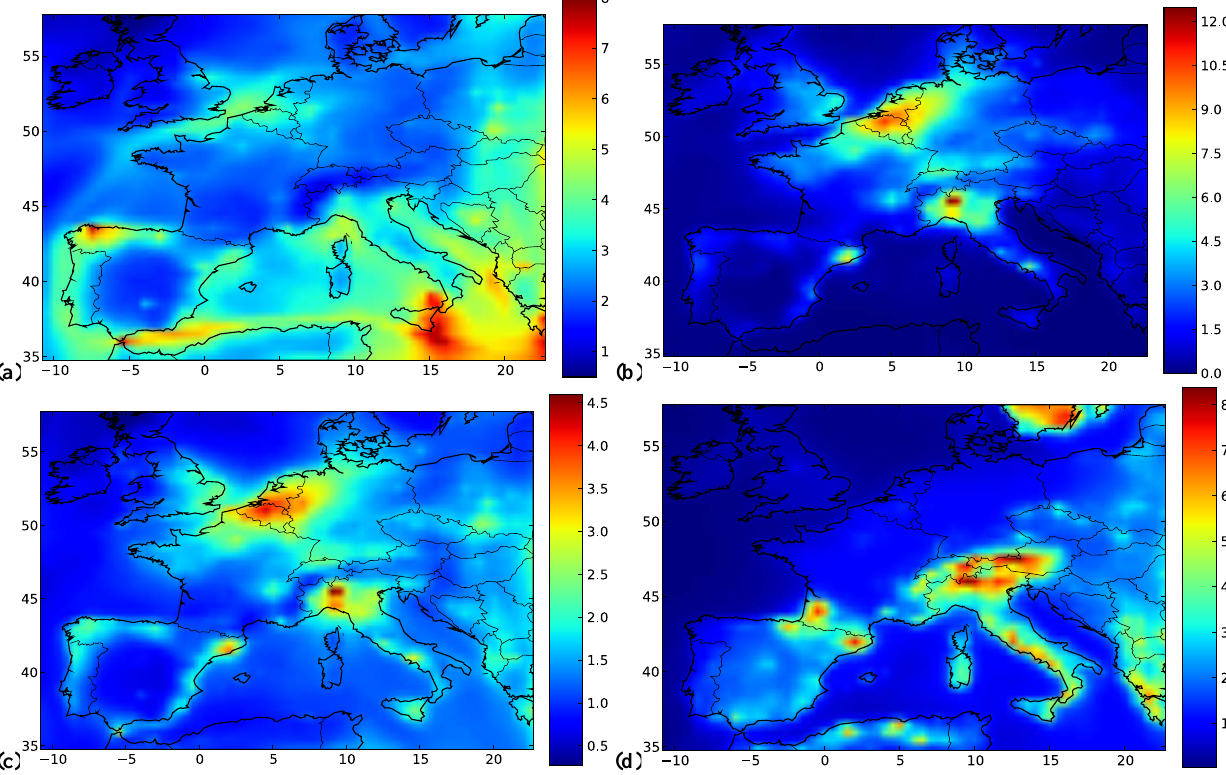
Fig. 3. Contributions (µg/m 3 ) of secondary chemical components to PM 2 . 5 over Europe: (a) sulfate, (b) nitrate, (c) ammonium, (d)